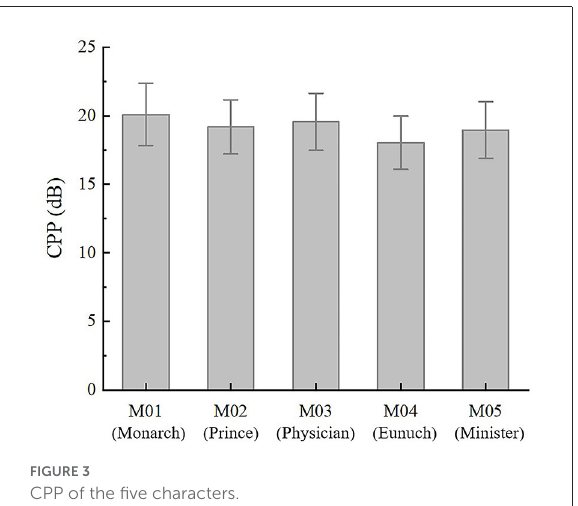
FIGURE3 CPP of the five